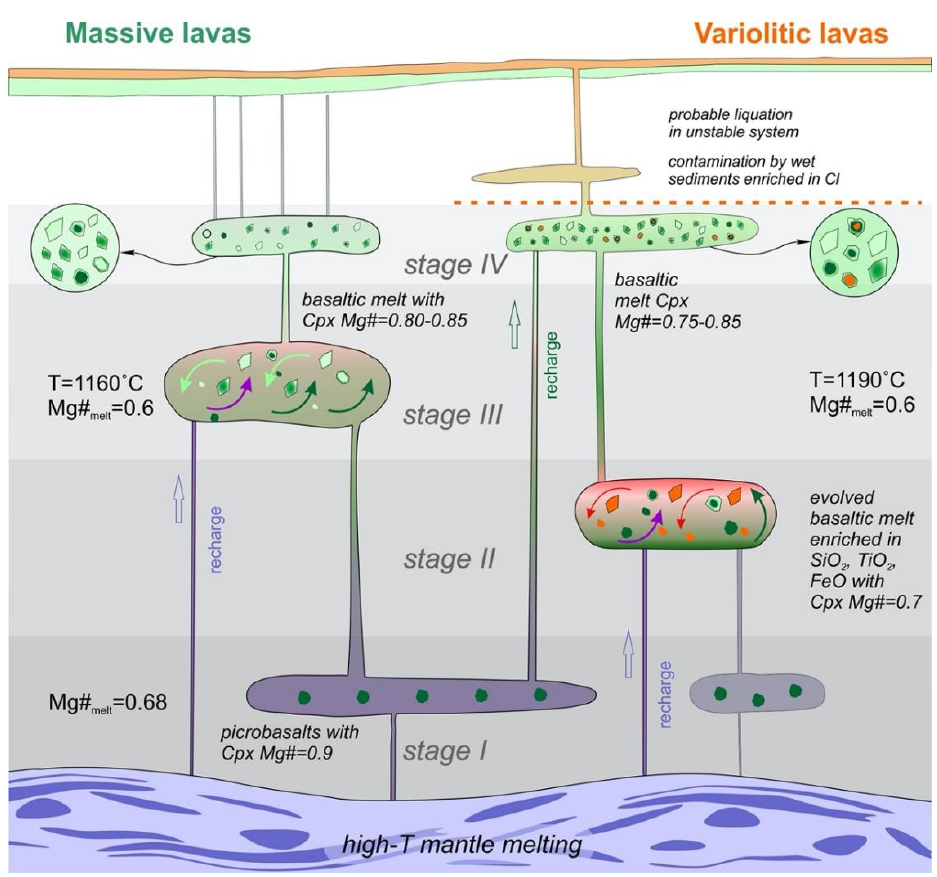
Figure 8. Schematic model of the evolution of the magmatic system for the Suisaarian massive and variolitic lavas based on the data for the clinopyroxene phenocrysts. Clinopyroxene types correspond to Table 1. The orange dotted line indicates a lower restriction for the generation of variolitic textures.